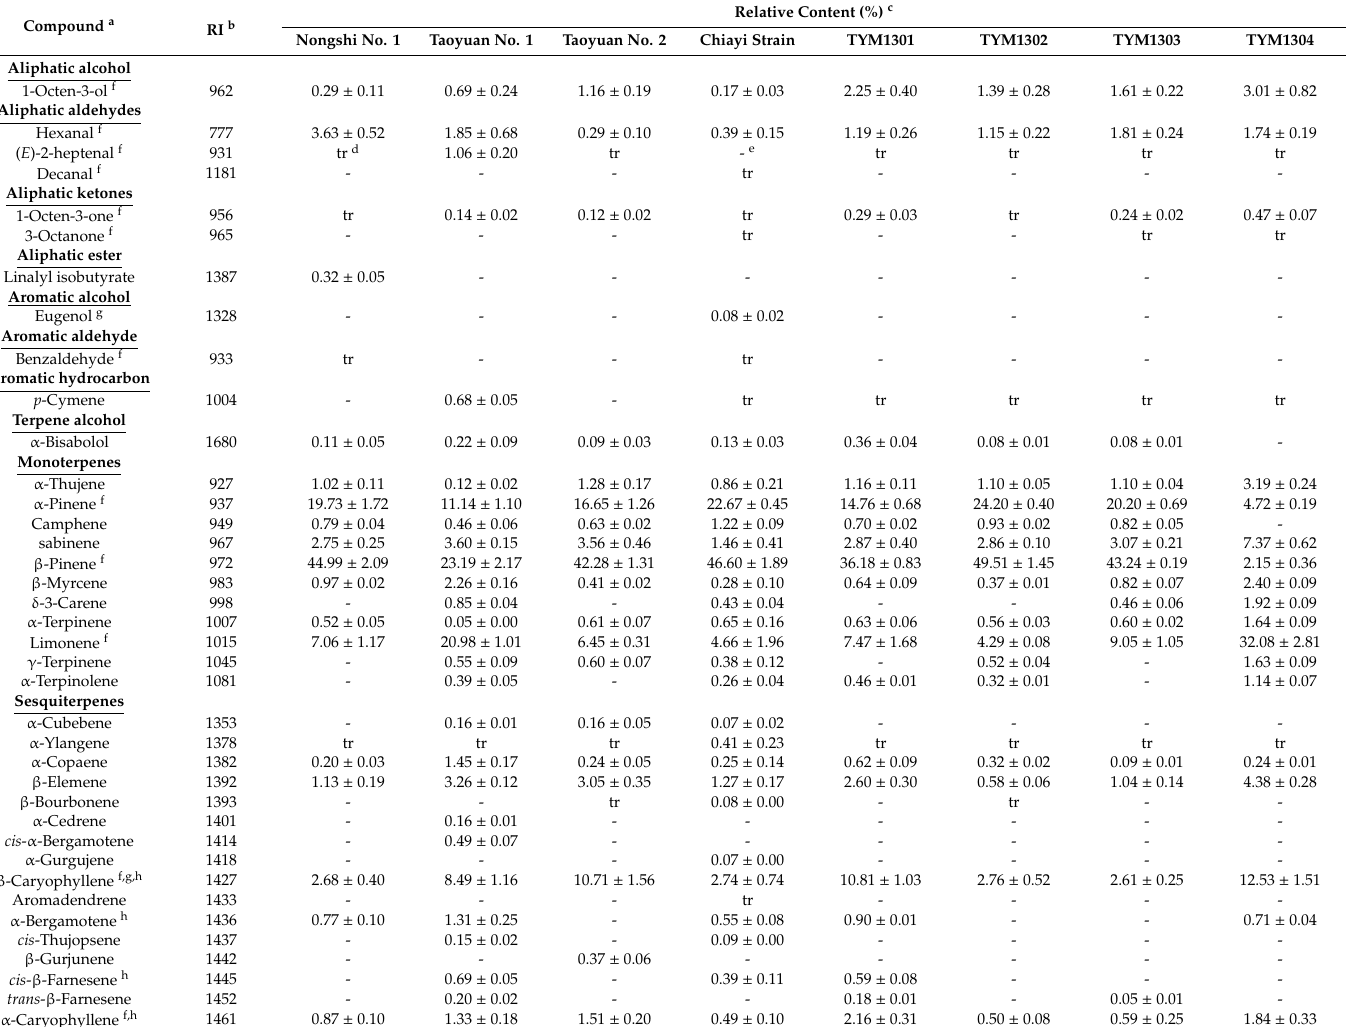
Table 2. Comparisons of volatile compounds from eight varieties of Hsian-tsao extracted using